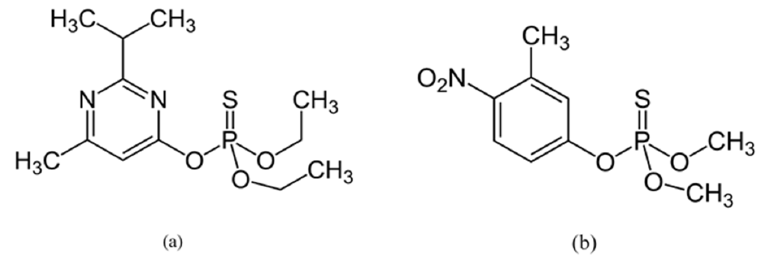
Figure 1. Chemical structure of: ( a ) diazinon; ( b ) fenitrothion.